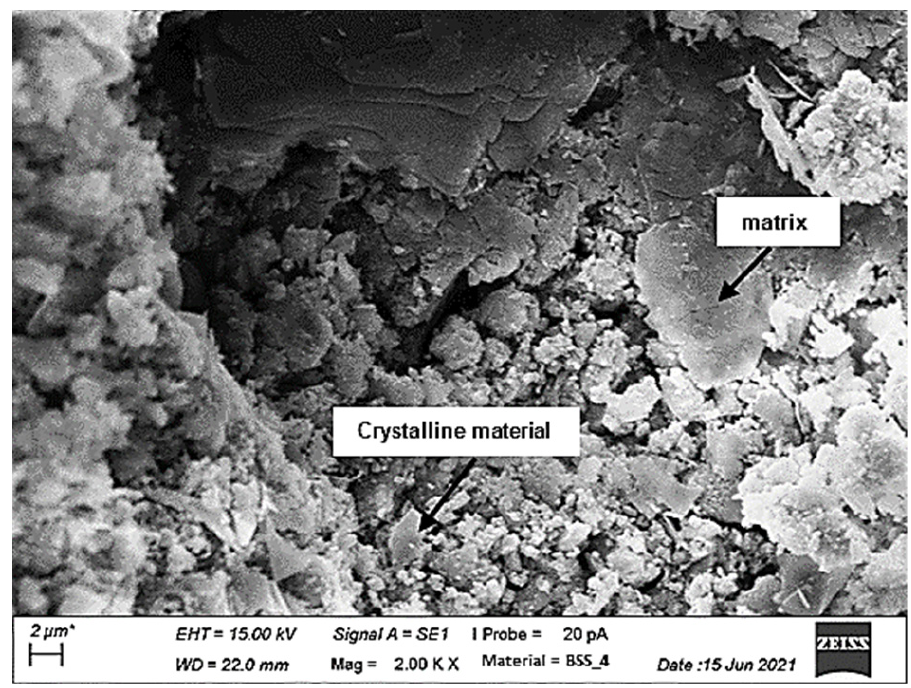
Figure 11. SEM image of the fracture surface of the brick scrap geopolymer at 2000× magnification.